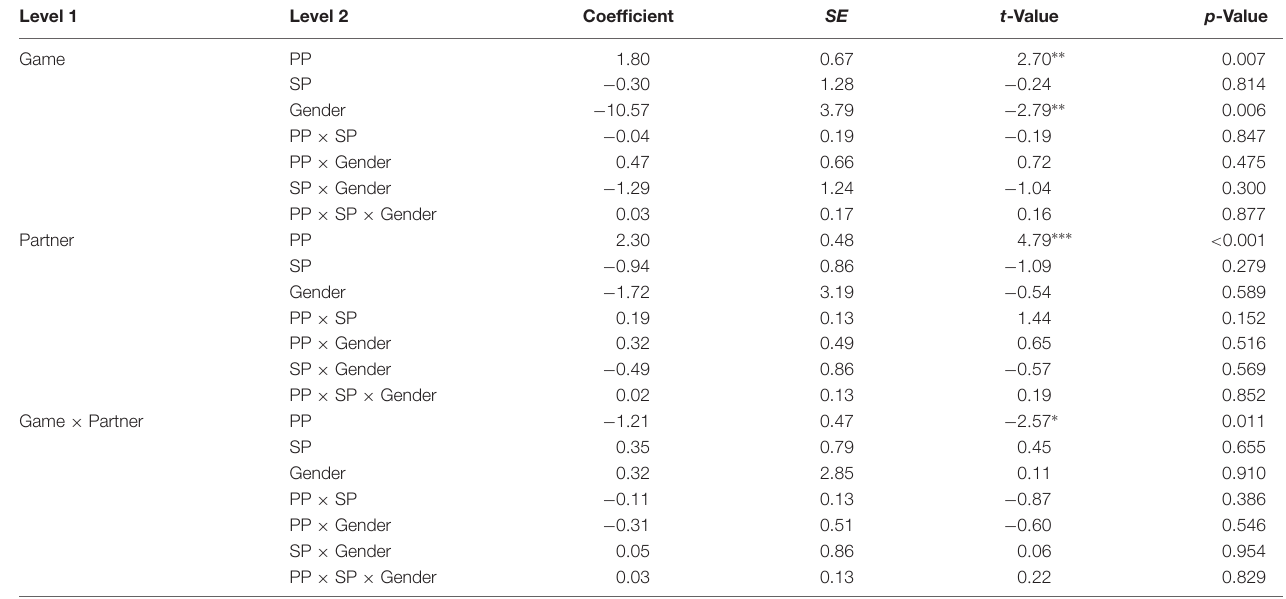
TABLE 3 | Fixed effects of cross-level